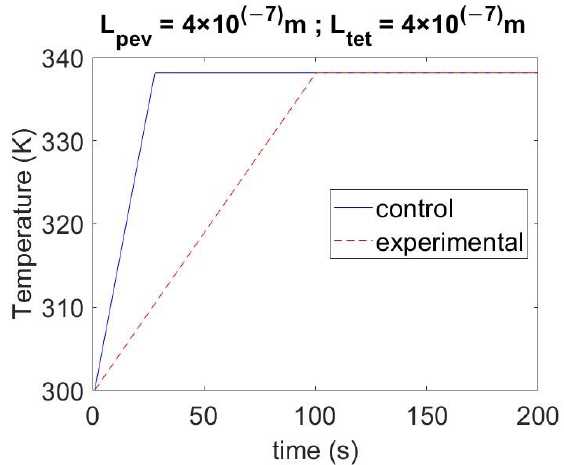
Figure 6. The temperature of the perovskite layer with the base condition.